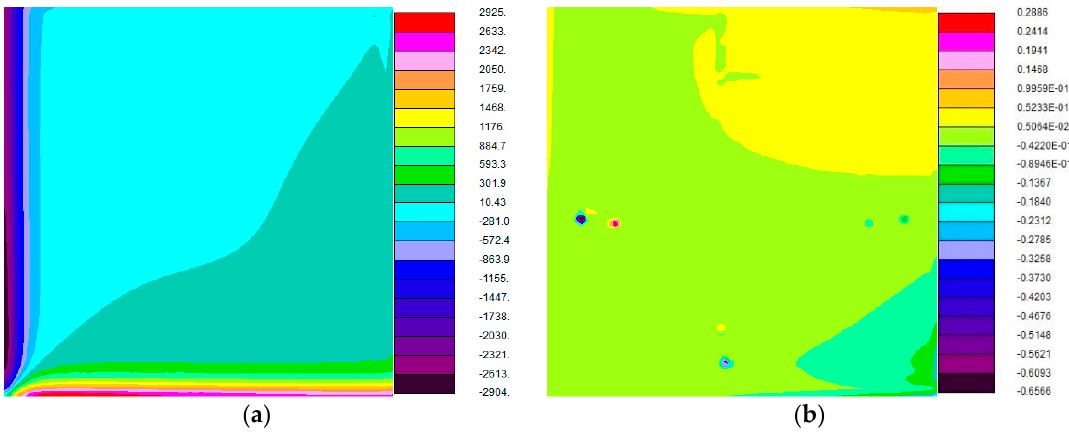
Figure 7. The plate LHC heat flux q LHC distributions of cross-flow plate heat exchanger ( a ) Heat transfer model with LHC; ( b ) Heat transfer model without LHC.